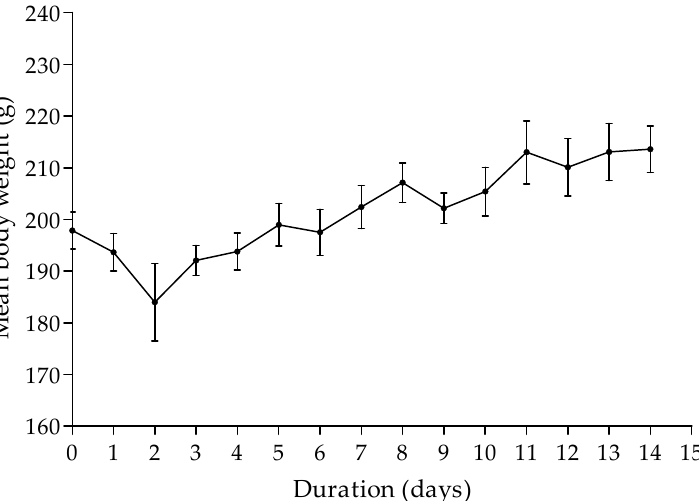
Figure 1. The average weight of animals measured over a period of 14 days. Values are mean (standard error, n = 3).